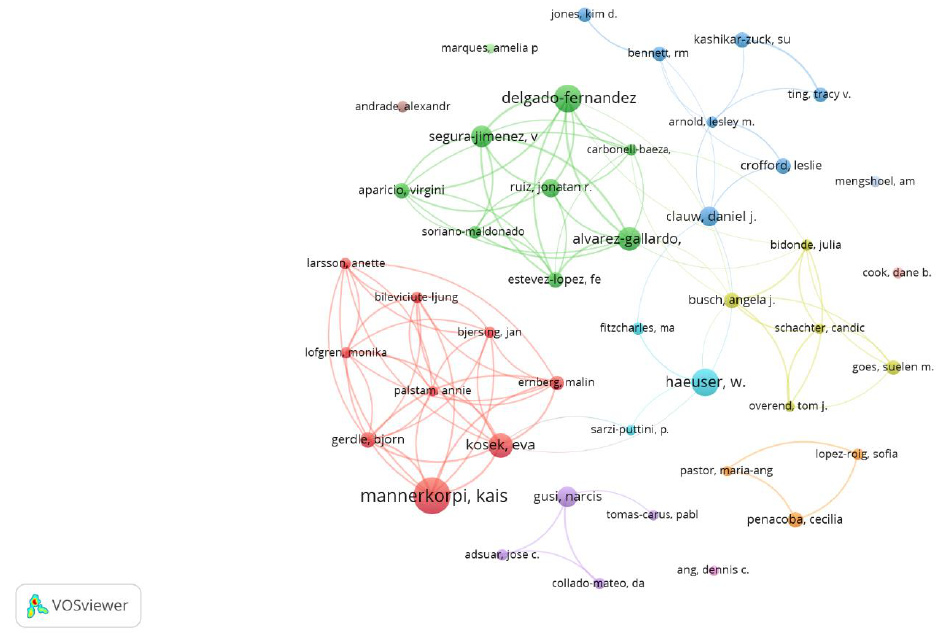
Figure 3. Most prolific co-authors according to the number of documents and publication collabo- rations.